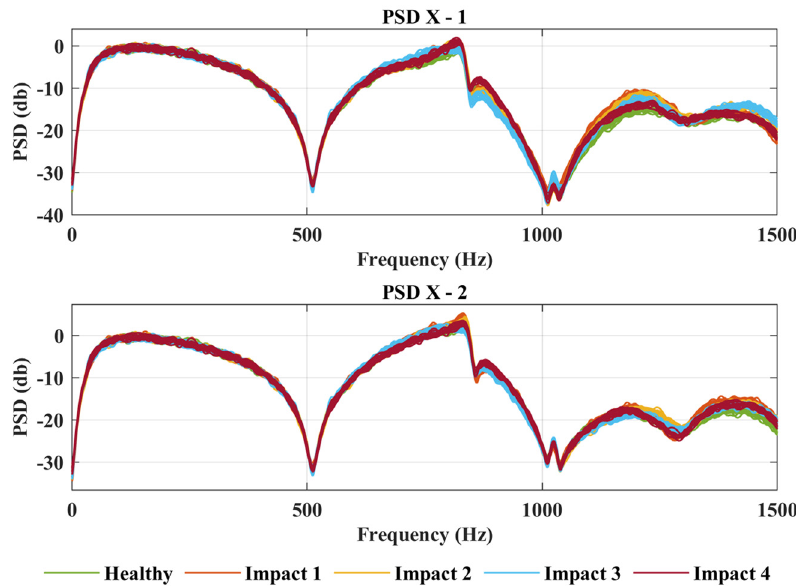
Figure 5. Power spectral density (PSD) of accelerometers A1 and A2.